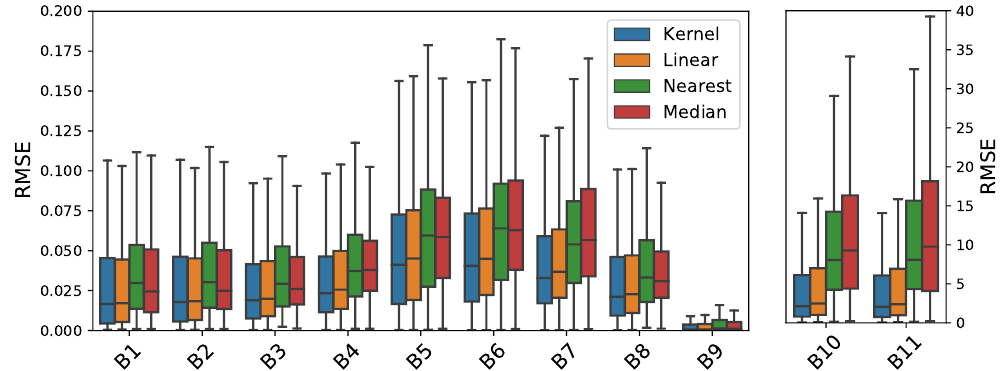
Figure 9. Root mean square error between the estimated and actual background pixels in the cloud-free areas. Distribution of the errors is shown separately for all Landsat bands for the four background estimation